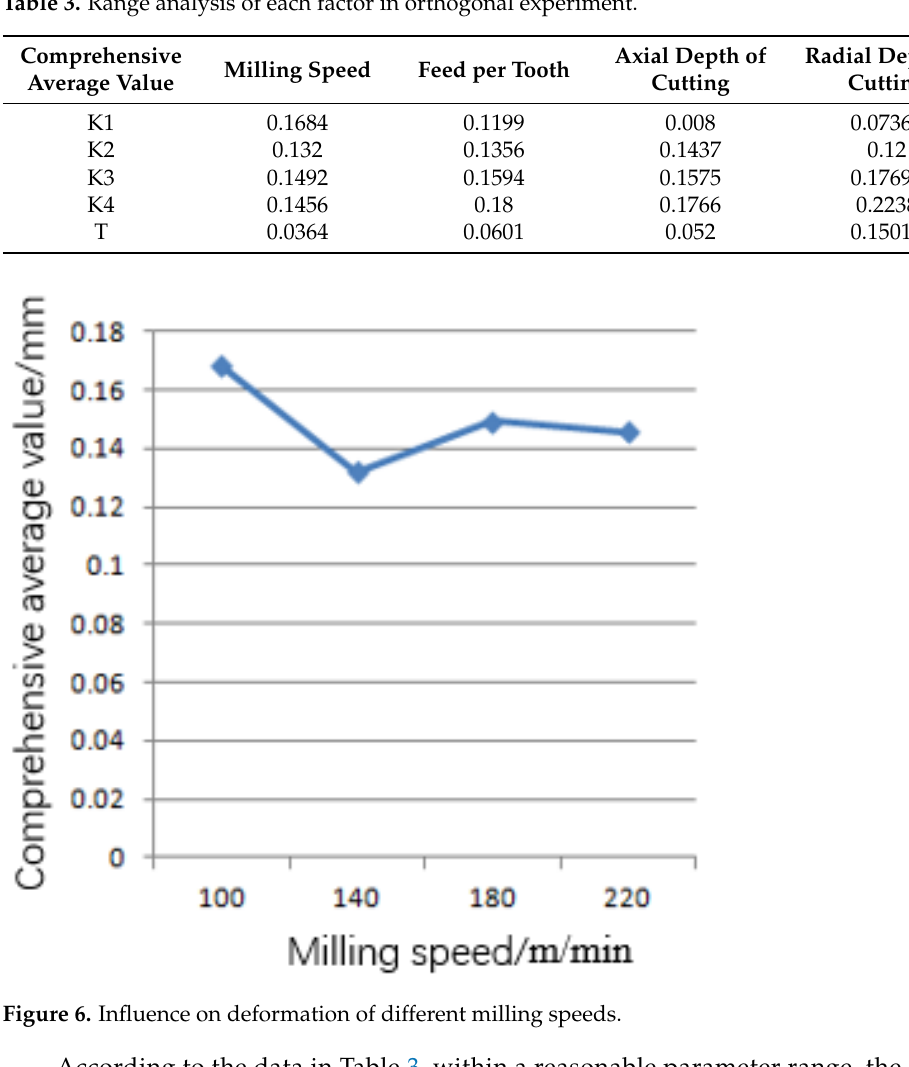
Table 3. Range analysis of each factor in orthogonal experiment.